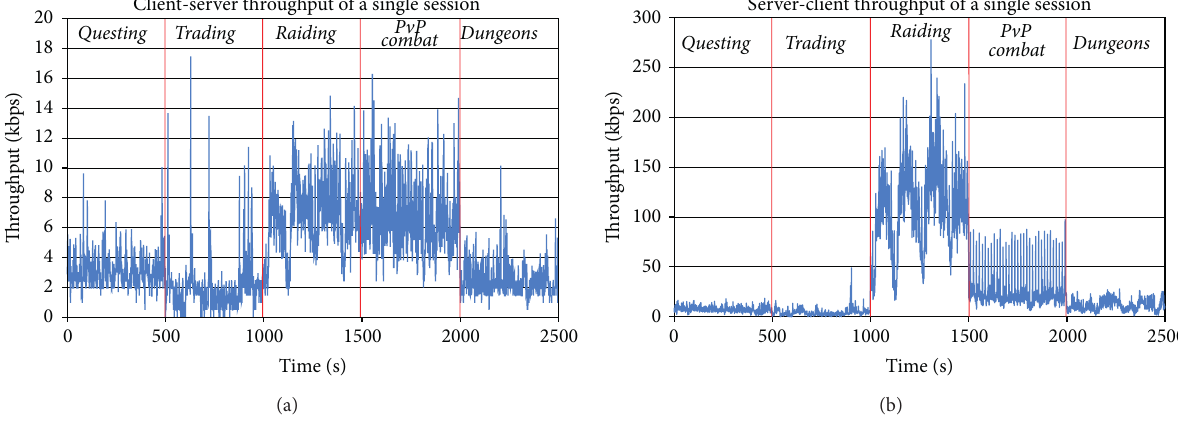
Figure 1: Bandwidth usage of the original game for different categories: (a) client-server and (b) server-client (the trace presented in the figure is a set of characteristic fragments obtained from separate